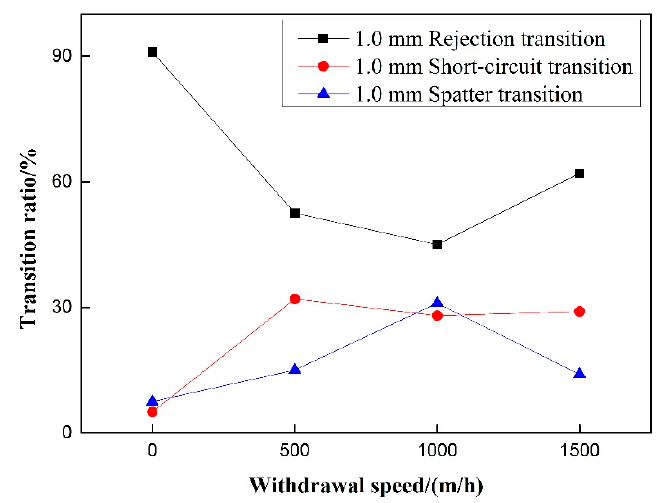
ff ect of withdrawal speed on transition ratio under 1.0 mm withdrawal quantity. Materials 2019 , 12 , x FOR PEER REVIEW Figure 17. Effect of withdrawal speed on transition ratio under 1.0 mm withdrawal quantity. Figure 17. E